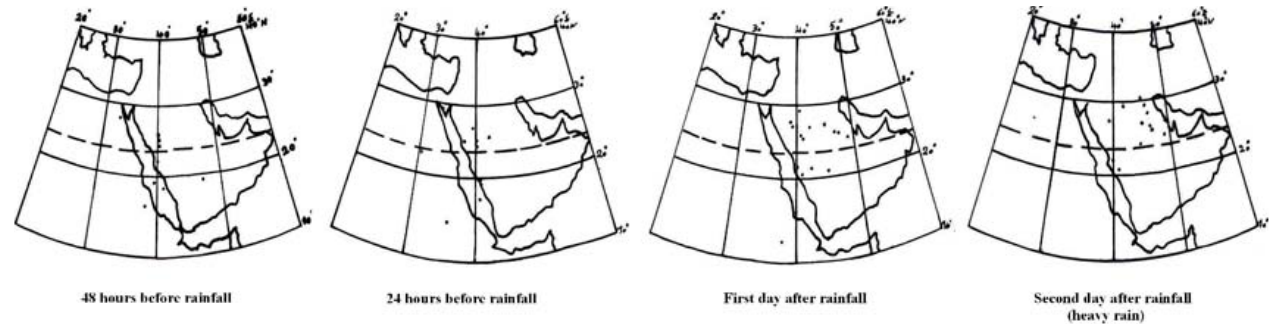
Fig. 18 The location of surface-level LP centers of the 20 selected floods two days before the rainfall (left pictures) and in first day and 2nd day of heavy rainfalls (right pictures)